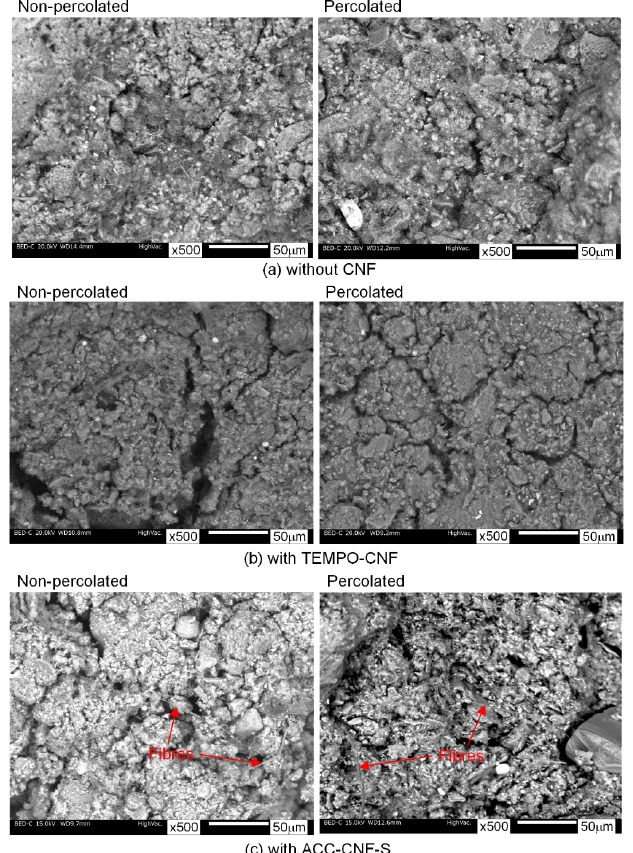
Figure 17. SEM microphotograph of specimens.